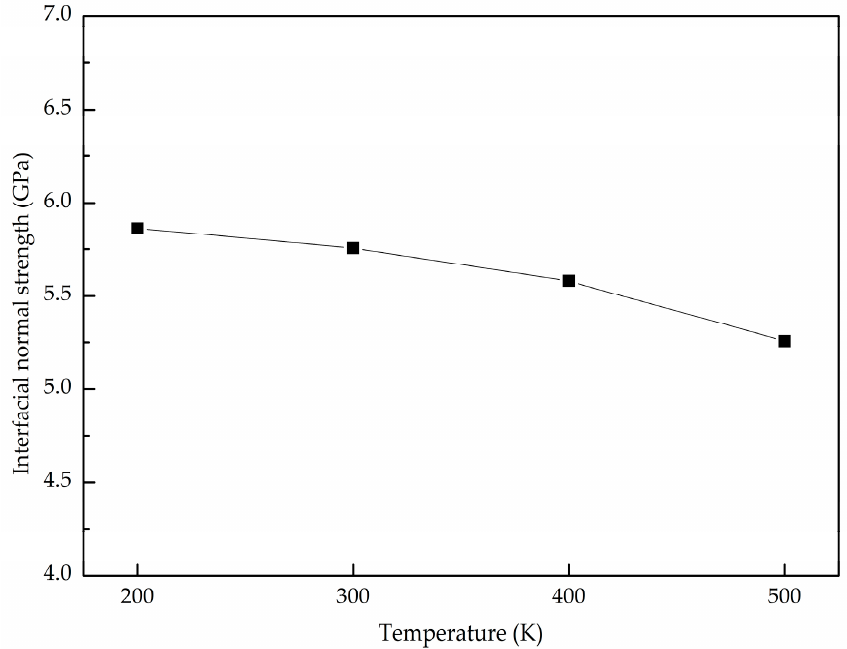
Figure 5. Normal interfacial strength of the GANC at different temperatures.